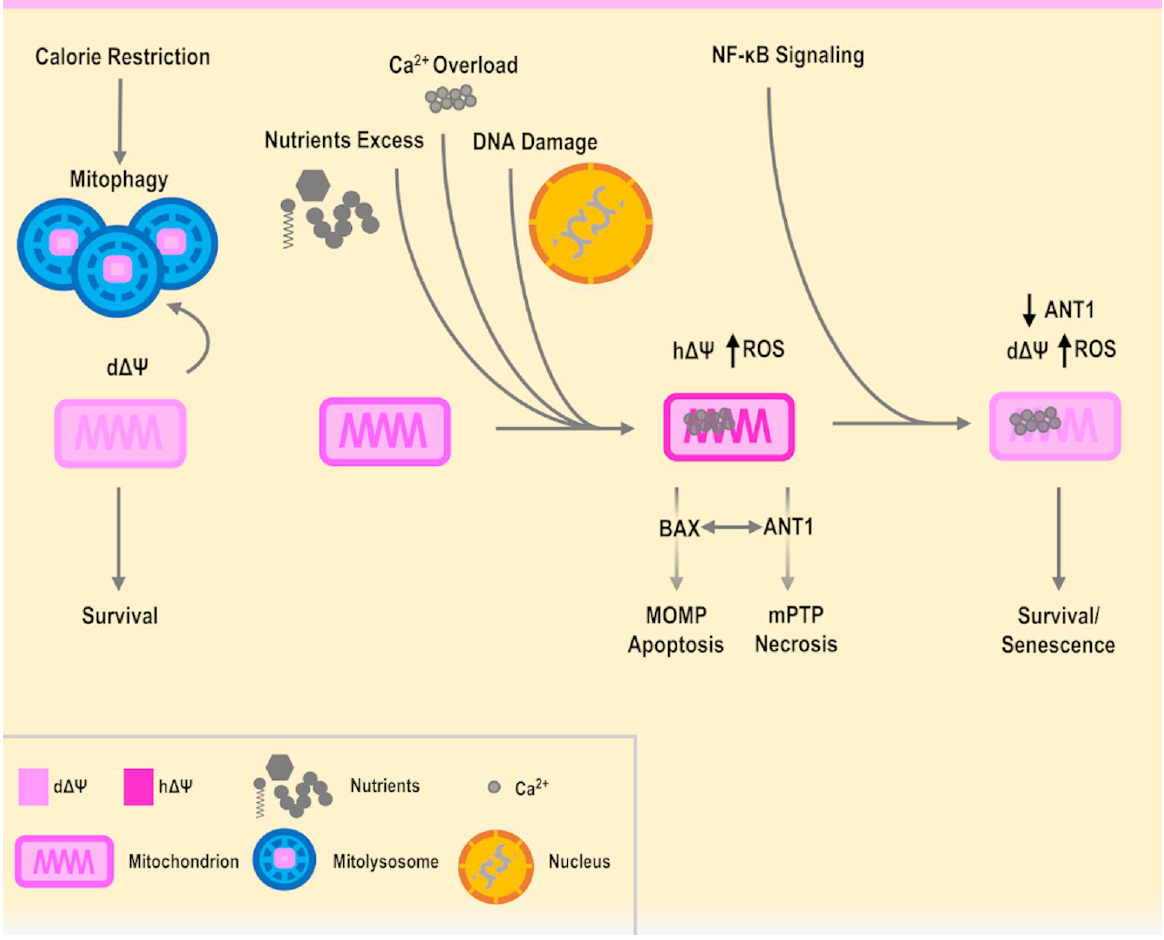
FIGURE 1: The mPTP, a potential hub in the regulation of cell survival and cell death. Calorie restriction features mitochondrial depolariza- tion and mitophagy, promoting survival. During mitophagy, mitochondria are degraded inside mitolysosomes. In contrast, in presence of death stimuli such as excessive nutrients, calcium overload or DNA damage, cells may undergo cell death. The balance between apoptosis and necrosis could be regulated by the mitochondrial membrane potential coupled with the levels of ANT1 activity and the interactions with other players such as BAX. Further, pathways increasing the expression of ANT1 could foster cell death through the mPTP, while pathways decreasing it (e.g. NF- κB signaling pathway) could favor mPTP closing and cell survival. See the text for details. ΔΨ, mitochondrial membrane potential with d, depolarized and h, hyperpolarized; MOMP, mitochondrial outer membrane permeabilization; mPTP, mitochondrial perme- ability transition pore. Organelles, damaged DNA, Ca 2+ and nutrients (e.g. carbohydrates such as glucose, proteins, fatty acids) are simplified graphical